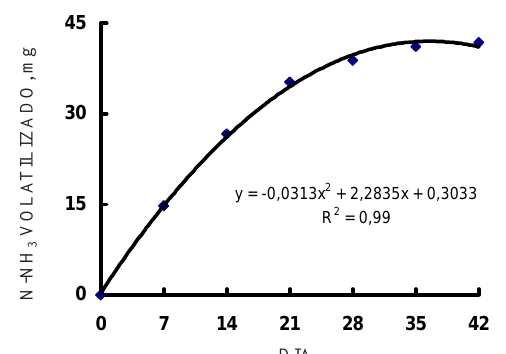
Figura 1. Perdas acumuladas de amônia durante a compostagem de uma mistura de estercos de galinha e de gado, sem emprego de